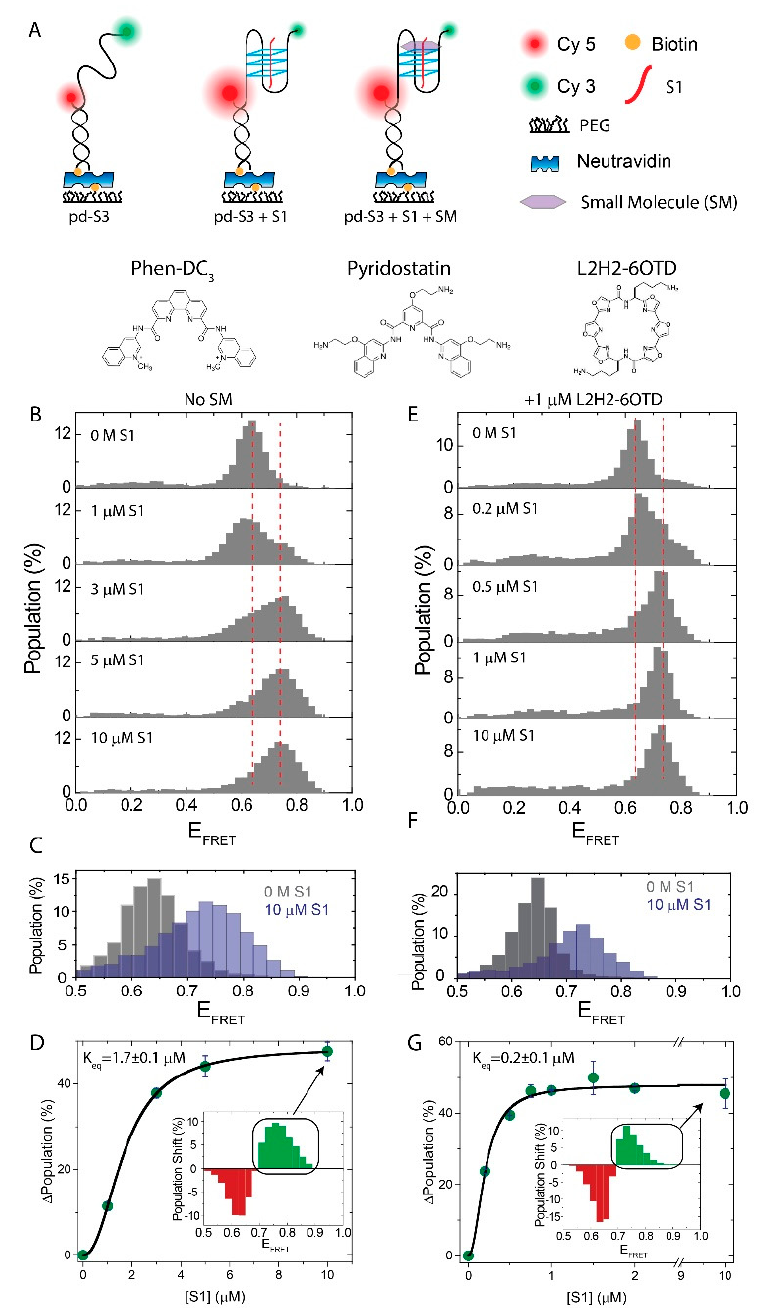
Figure 1. The e ff ect of L2H2-6OTD on the i-GQ formation in 3 + 1 GGG configuration in the 150 mM K + . ( A ) Schematic of the DNA constructs and the smFRET assay. The bottom panel shows the chemical structures of the SMs used in the measurements. ( B ) S1 was titrated from 0 M to 10 µ M in the absence of SM. Higher FRET states were populated as [S1] increased, suggesting i-GQ formation. The red dashed lines indicate the peak of the FRET distribution at 0 M and 10 µ M S1. ( C ) 0 M and 10 µ M S1 data were overlaid to illustrate the shift. ( D ) The transition to the i-GQ state was quantified by subtracting the FRET distribution at 0 M S1 from that at corresponding [S1]. The total positive higher FRET population (green bars at the inset) was plotted as a function of [S1]. The black line was a Hill function fit. ( E – G ) were the equivalents of ( B – D ), respectively, when 1 µ M L2H2-6OTD was maintained in the chamber, during S1 titration. K eq decreased from 1.7 µ M in the absence of SM to 0.2 µ M in the presence of 1 µ M